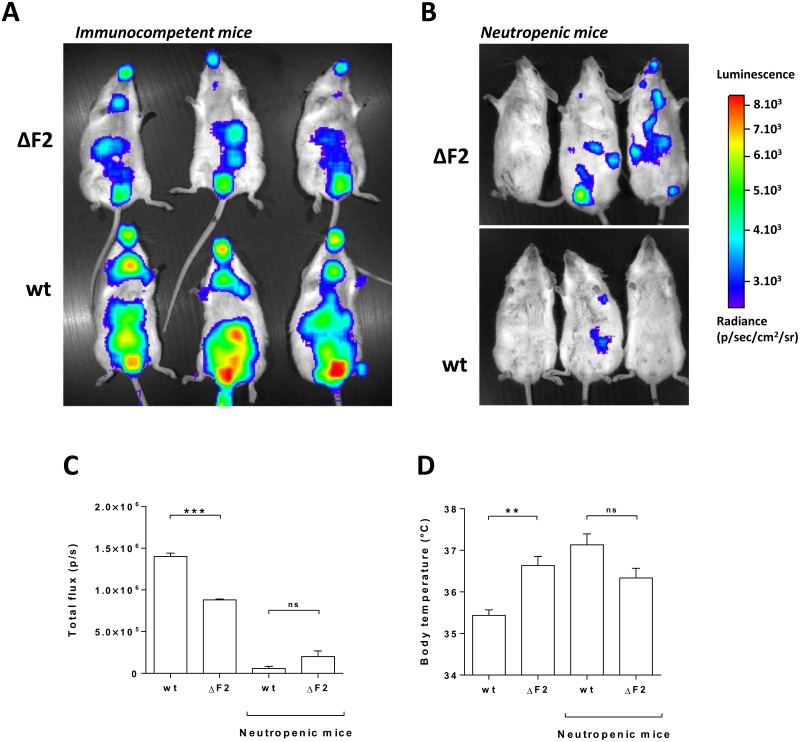
Infection of NF-kB luciferase transgenic mice.(A) Groups of 3 immunocompetent mice were infected with 1x105 PFU of the wt or the ΔF2 IAV. Four days pi, mice were anesthetized and luciferine was intra-nasally instilled (0.75 mg.kg-1). Bioluminescence was then measured using the IVIS system. (B) Bioluminescence analysis of neutropenic mice infected with 1x105 PFU of the wt or the ΔF2 IAV at day 4 pi. The scale on the right indicates the average radiance: the sum of the photons per second from each pixel inside the ROI/number of pixels (photons/sec/cm2/sr). (C) Bioluminescence activities of the 4 groups of mice were quantified using ‘Living Image’ software and represented as a diagram (***: p-value<0.001; ns: non-significant). (D) Body temperature measurement of immunocompetent mice and neutropenic mice challenged by wt or ΔF2 IAV at day 4 pi (**: p-value<0.01; ns: non-significant).